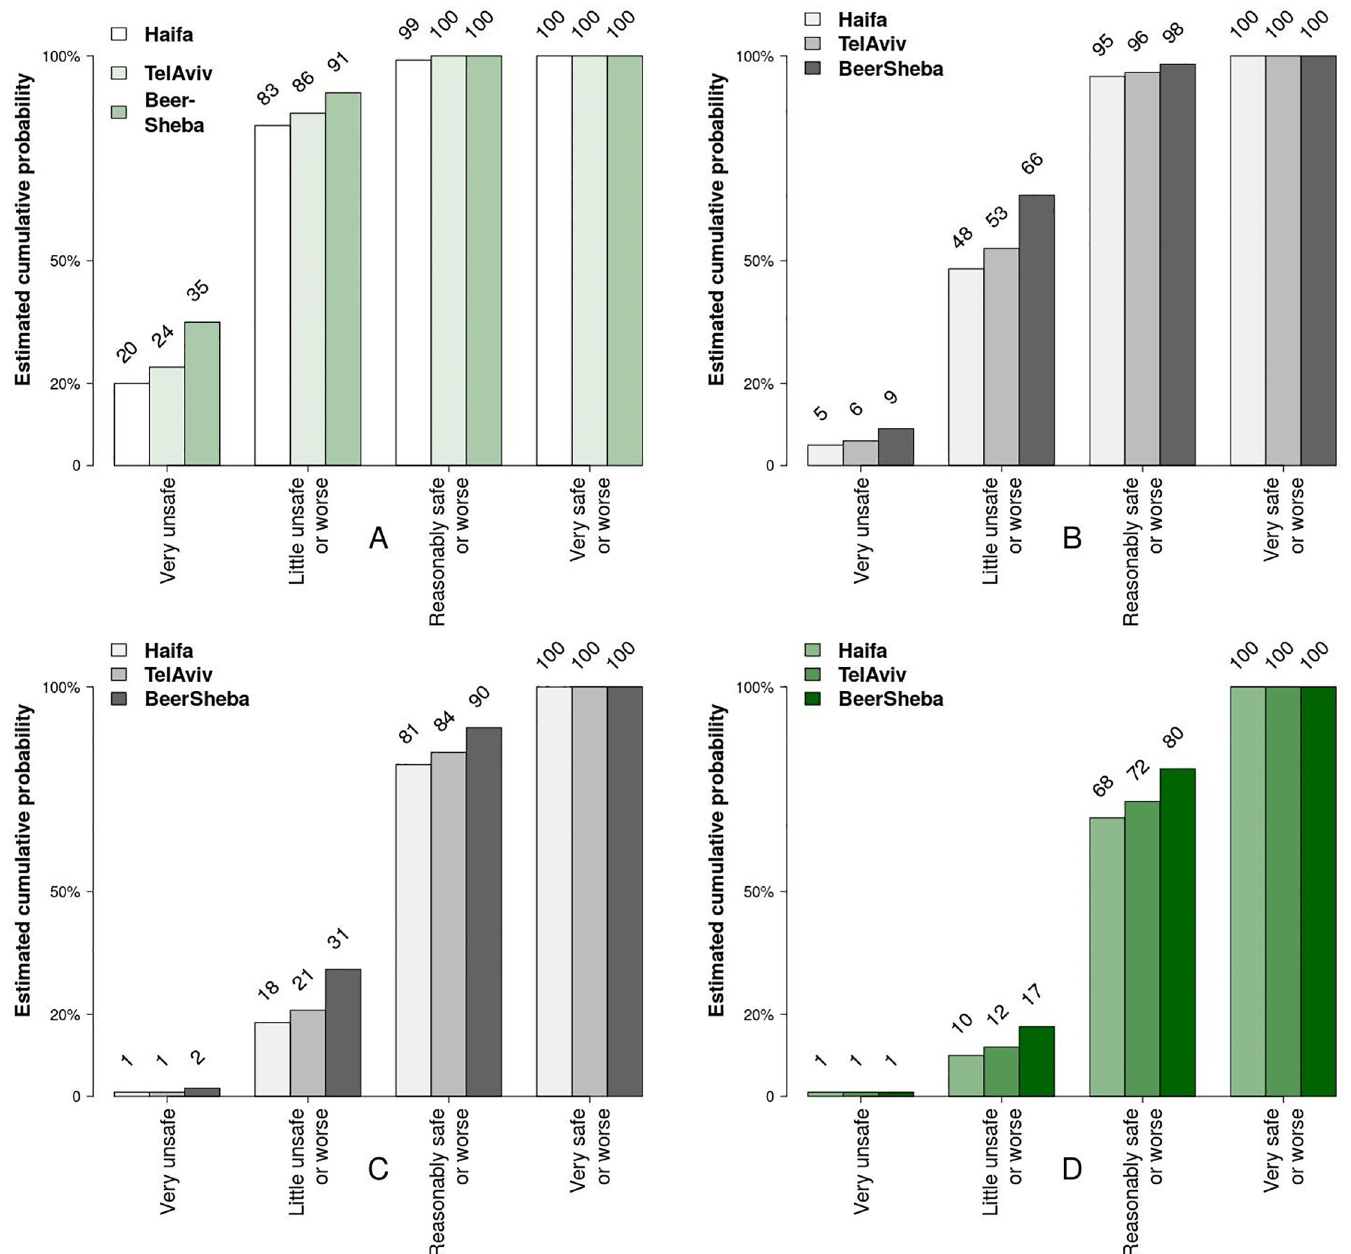
Fig 6. Cumulative probability estimates of FoS assessments for different cities and different levels of illumination (a model response test). Illumination levels: A = very weak; B = reasonable; C = good; D = strong. Note: The estimates are based on Model 2 (Table 4) and are generated by changing illumination levels only, while holding the values of all other variables constant and equal to 1 on a 4-point Likert scale (from 0 (Low) to 3 (High)).